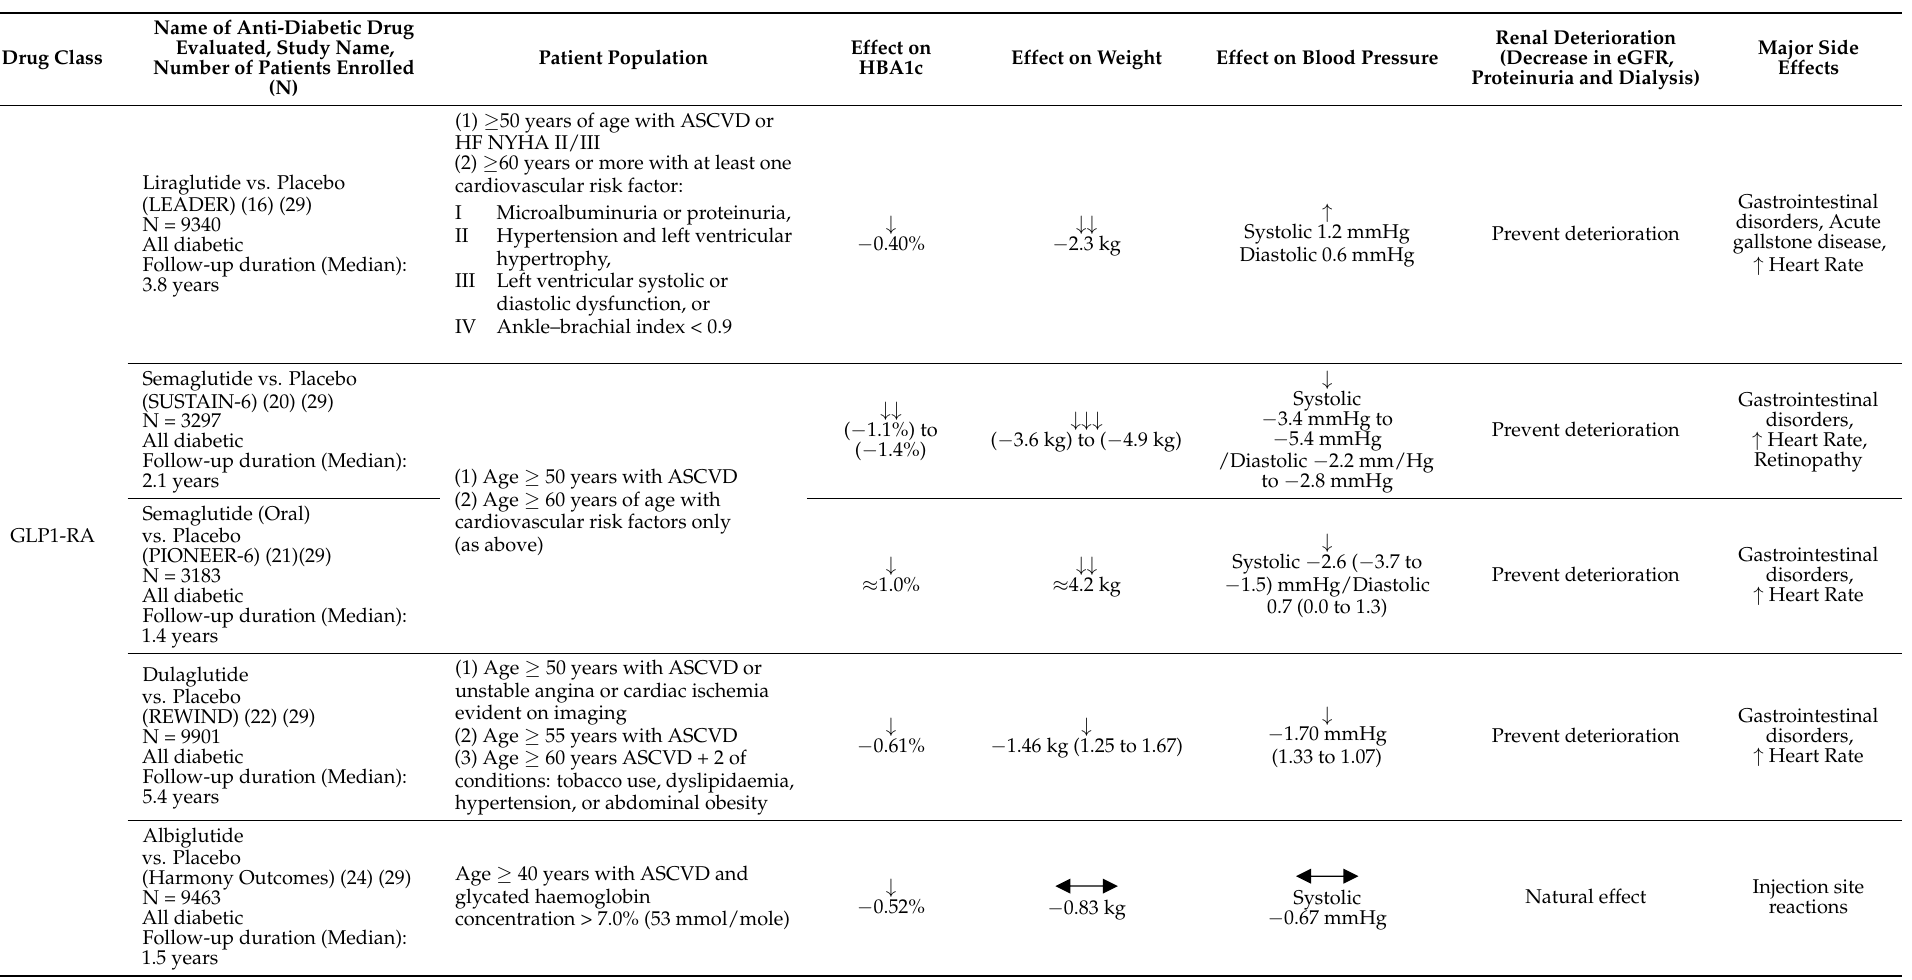
Table 1. Major pharmacological effects and side-effects from cardiovascular outcome trials evaluating novel anti-diabetic